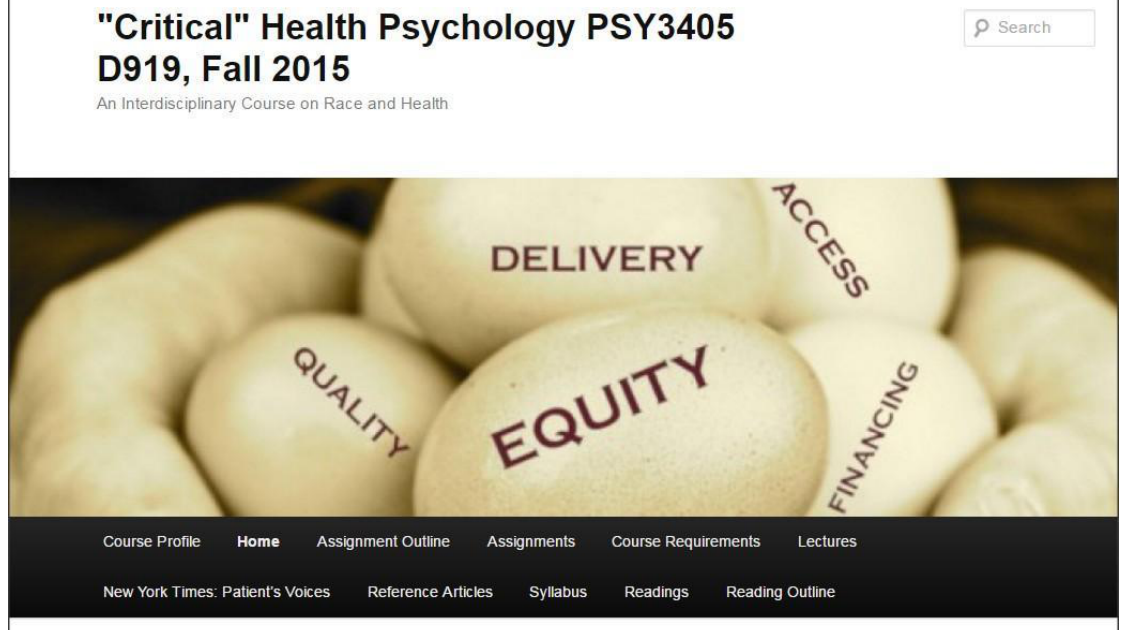
Figure 1. Detail of the Health Psychology landing